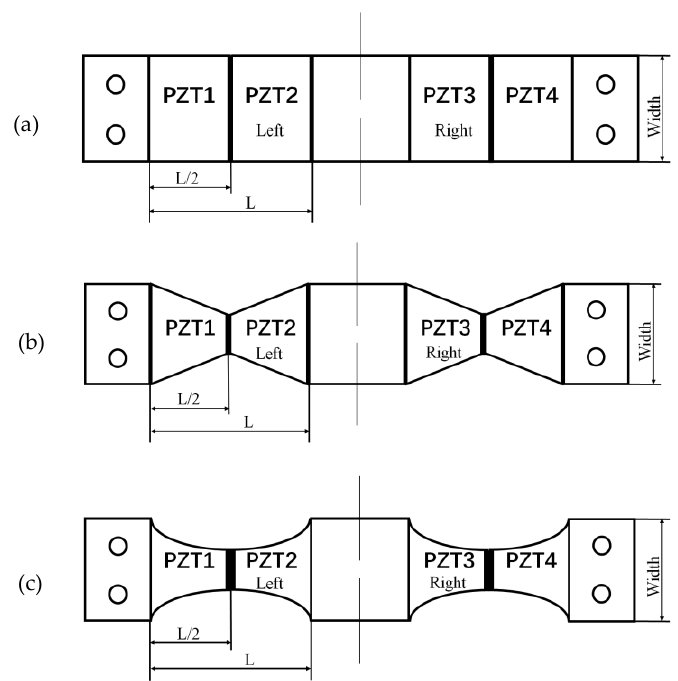
Figure 4. Three kinds of shapes. ( a ) Rectangular. ( b ) Trapezoidal. ( c ) Concave parabolic. From calculation of the converting factors corresponding to the above three shapes with the same width at the clamped end, it can be seen that, the double trapezoidal shape is better than the rectangular, whereas the concave parabolic shape is better than the double trapezoidal.